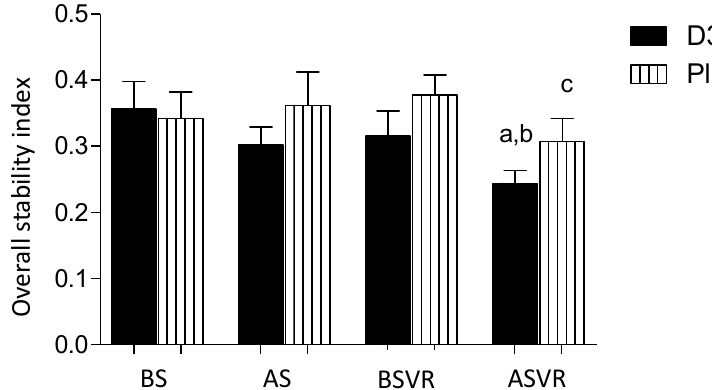
Figure 4. Vitamin D supplementation improves the effects of rehabilitation on the overall postural stability of patients after an anterior cervical interbody fusion surgery. Columns, mean and bars, standard deviations (SDs). a, p < 0.05, significantly different compared with the before supplementation (BS) control; b, p < 0.05, significantly different compared with the D3-BSVR group by one-way ANOVA; and c, p < 0.05, significantly different compared with the Pl-BSVR group.